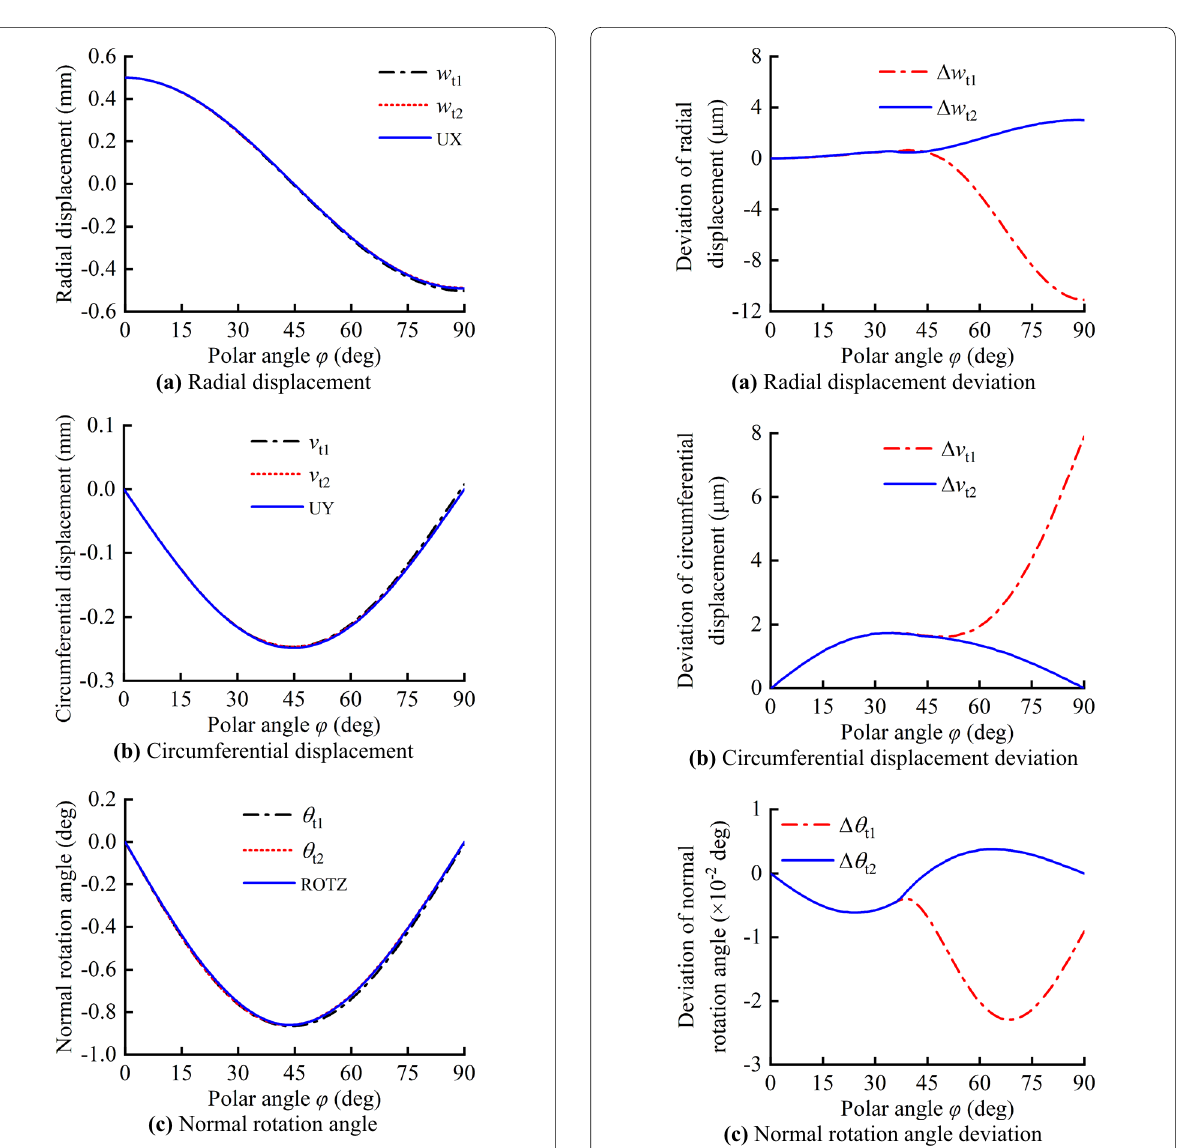
Figure 5 Displacements of ring assembled with elliptical cam